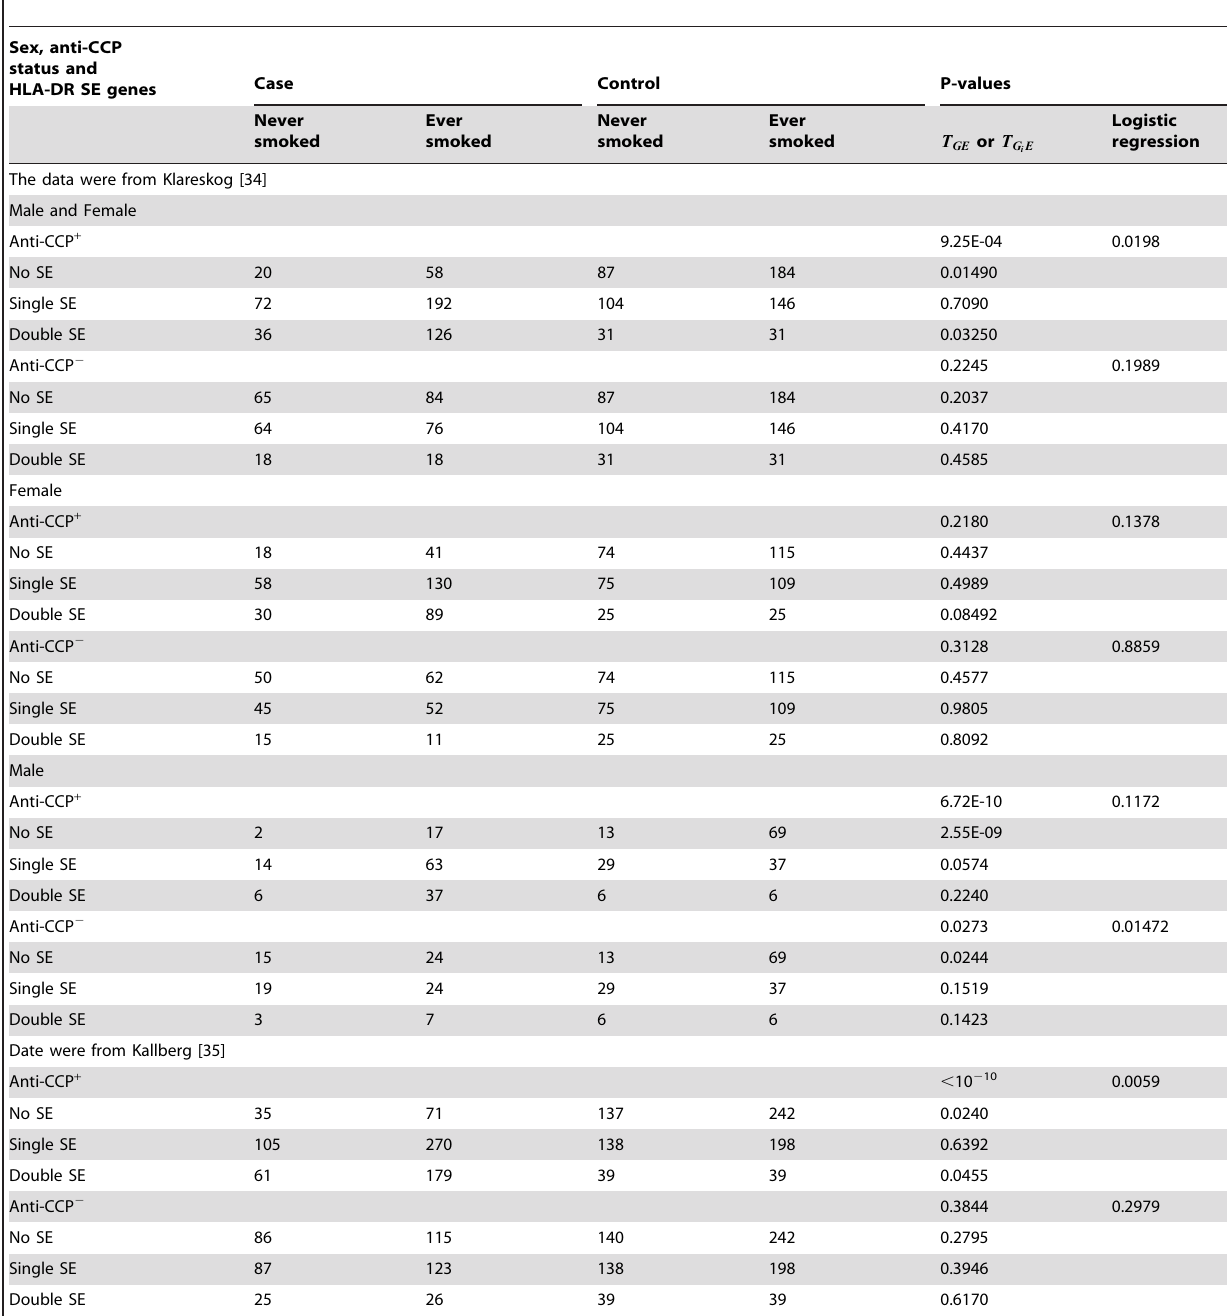
Table 6. Comparison of p-values for the mutual information-based statistics and logistic regression to the interaction between smoking and HLA-DR SE genes in the development of anticitrulline antibody-positive